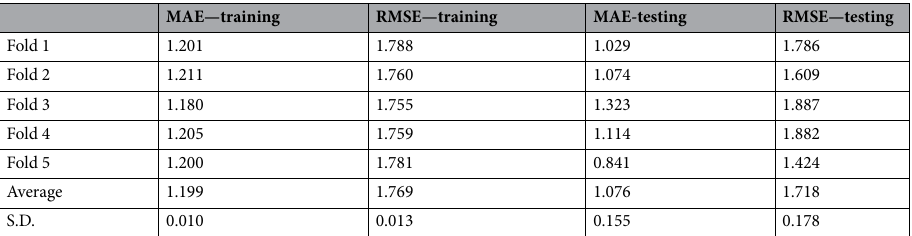
MAE—training RMSE—training